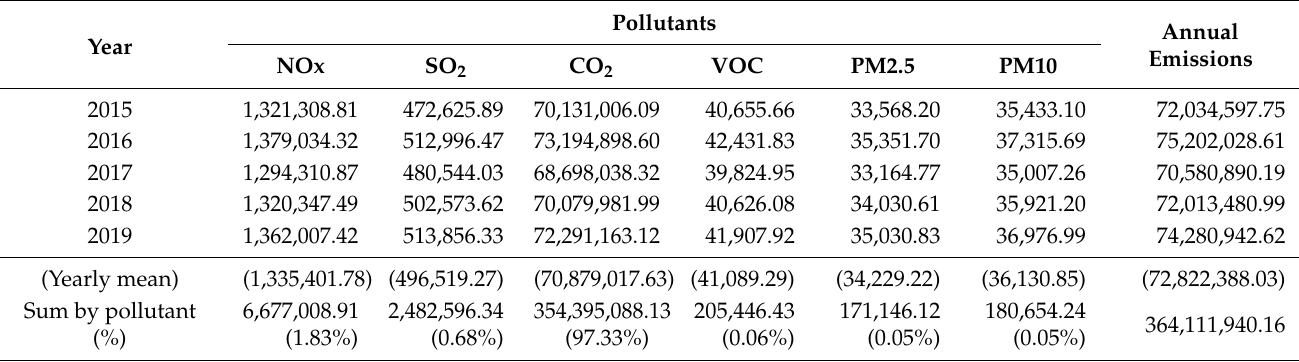
Table 11. Annual trend in ship pollutant emissions at Busan Port from 2015–2019 (ship activity phase: Hoteling)